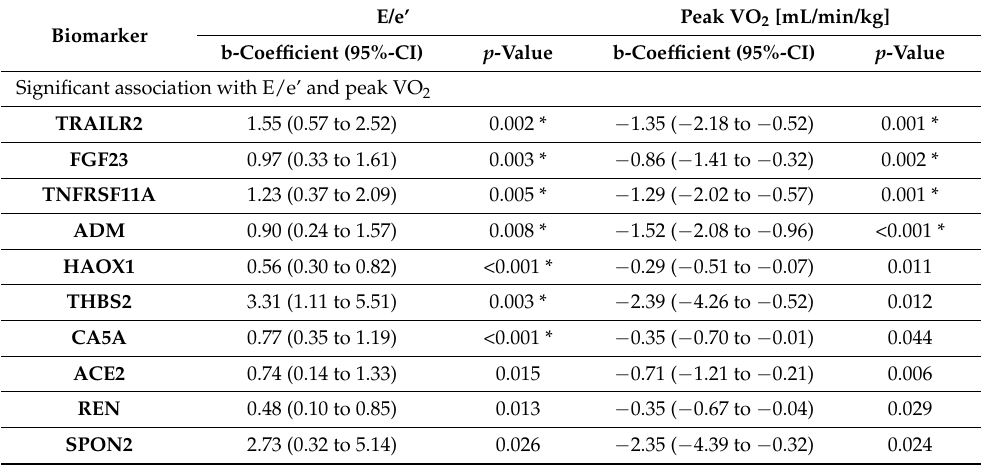
Table 1. Significant associations between biomarker expression levels and E/e’ and/or peak VO 2 in HFpEF patients at